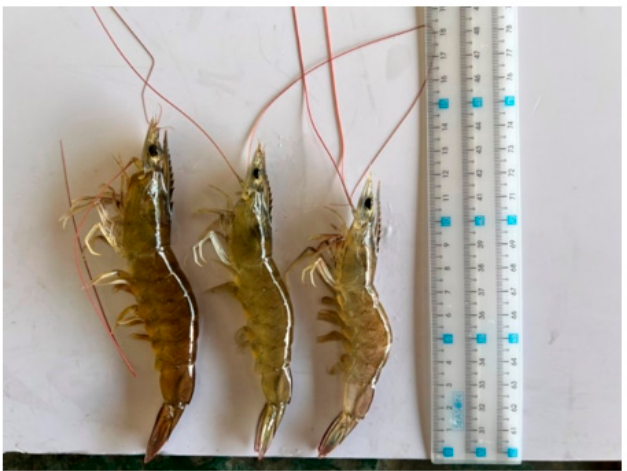
Figure 2. From left to right, the weight of one white shrimp ( Penaeus indicus ) is 35, 43, and 55 per catty, respectively. The white shrimp are harvested at 156, 120, 105 days after stocking, respectively.